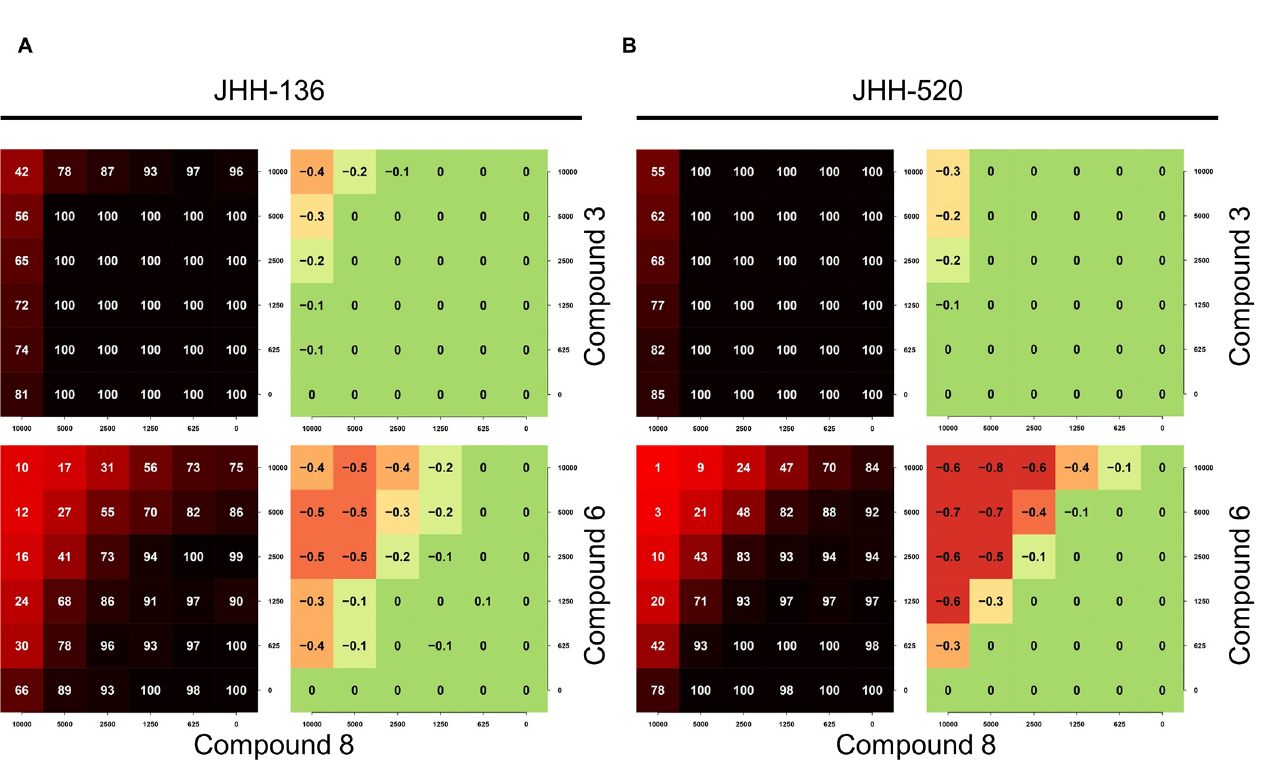
Fig 8. Compound 8 and 6 synergize to reduce the viability of patient-derived glioma cell lines. Combination (6 x 6) response profiles for compound 8 , 6 , and 3 in JHH-136 (A) and JHH-520 (B) cells. Each response profile is displayed as heatmaps of cell viability (percent response normalized to thapsigargin control; left panels) and DBSumNeg analysis (right panels).